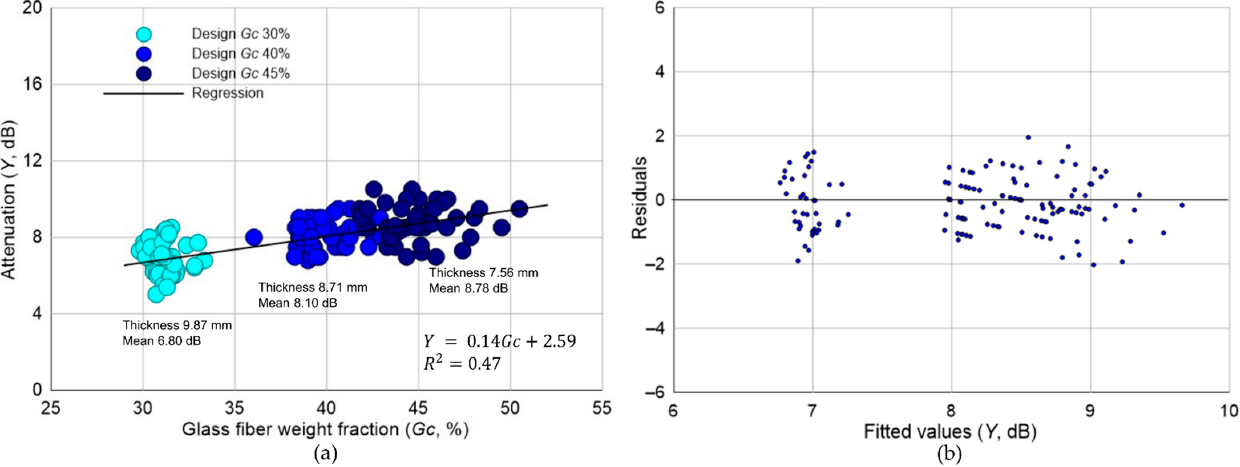
Figure 6. Ultrasonic wave attenuation as a function of the Gc . ( a ) Regression analysis results. ( b ) Residual analysis results.